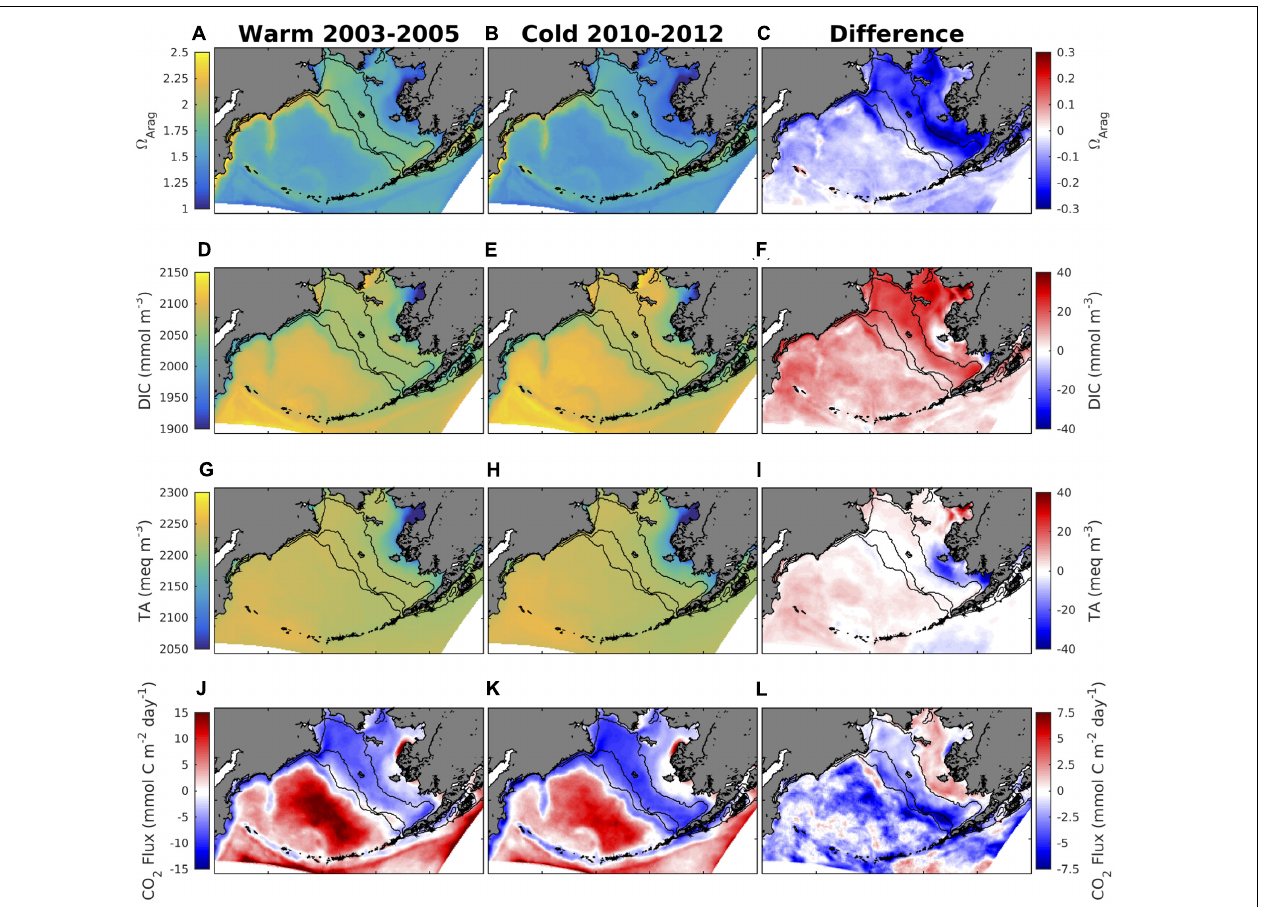
FIGURE 10 | (left) Model annual mean variables averaged over the warm and (middle) cold temperature regimes, and (right) the difference generated by the transition from warm to cold conditions. (A–C) Surface (cid:127) Arag , (D–F) surface DIC, (G–I) surface TA, and (J–L) air-sea CO 2 flux (where a positive value indicates a flux out of the